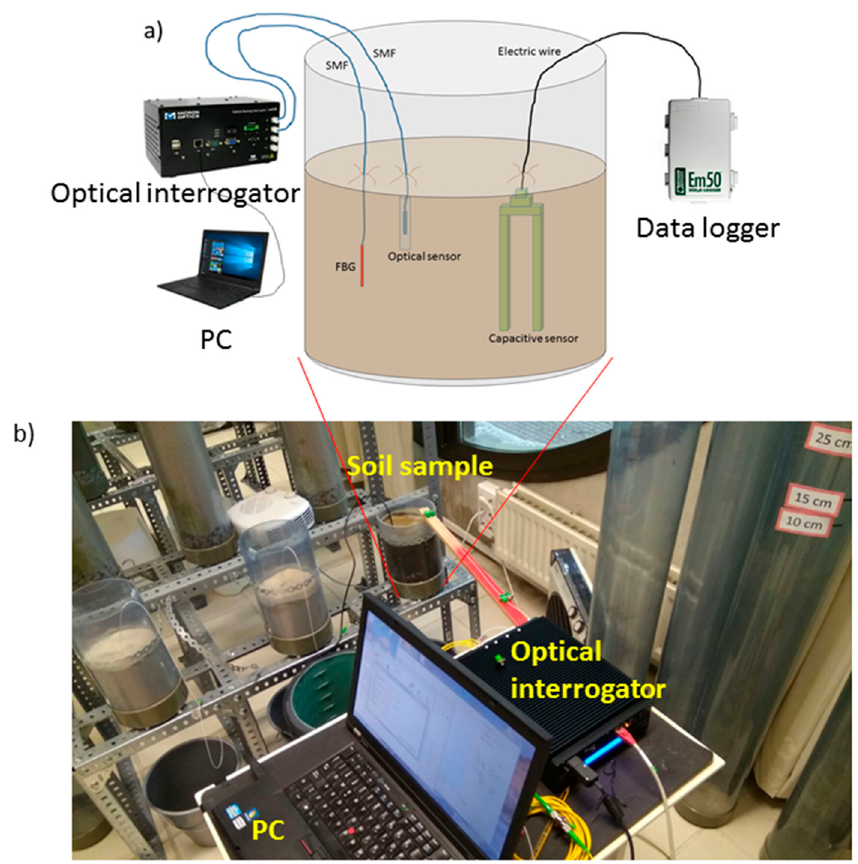
Figure 4. Experimental set up: ( a ) schematic set up and ( b ) real picture of the set up.